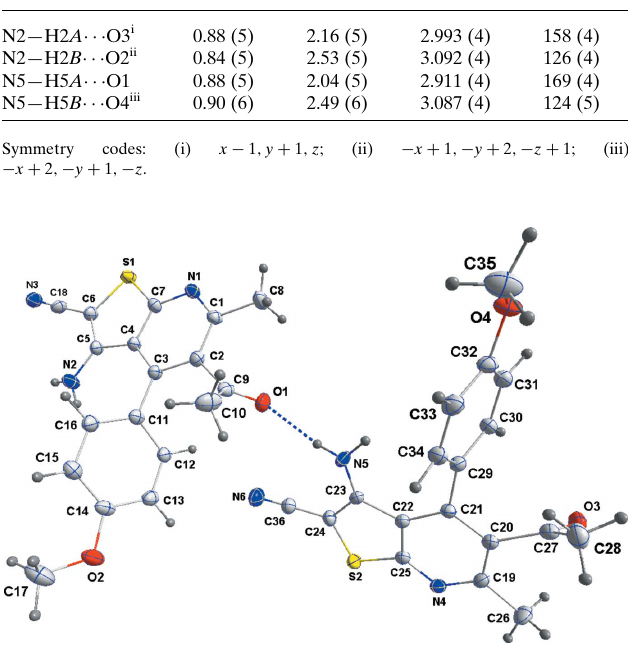
Figure 1 The asymmetric unit with the atom-labelling scheme and 50% probability displacement ellipsoids. The intermolecular N—H (cid:2)(cid:2)(cid:2) O hydrogen bond is shown as a blue dashed